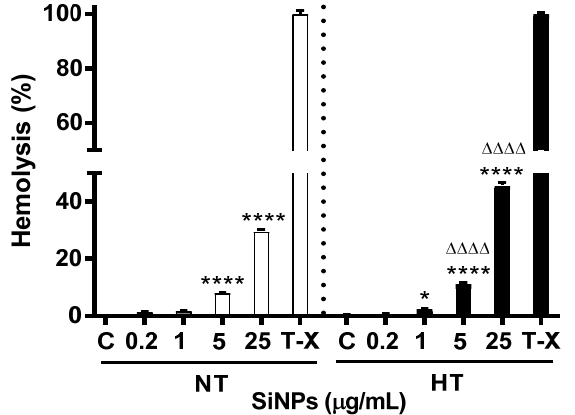
Figure 4. Hemolytic effect of various concentrations ( µ g/mL) of silica nanoparticles (SiNPs) in incubated normotensive (NT) and hypertensive (HT) rat erythrocytes. The results are expressed as % of positive control (0.1% Triton-X 100). Data are mean ± SEM ( n = 8 in each group). Statistical analysis by one-way analysis of variance (ANOVA) followed by the Holm–Sidak multiple comparisons test. * p < 0.05, **** p < 0.0001 vs. respective control and ∆∆∆∆ p < 0.0001 vs. respective concentration in NT group.